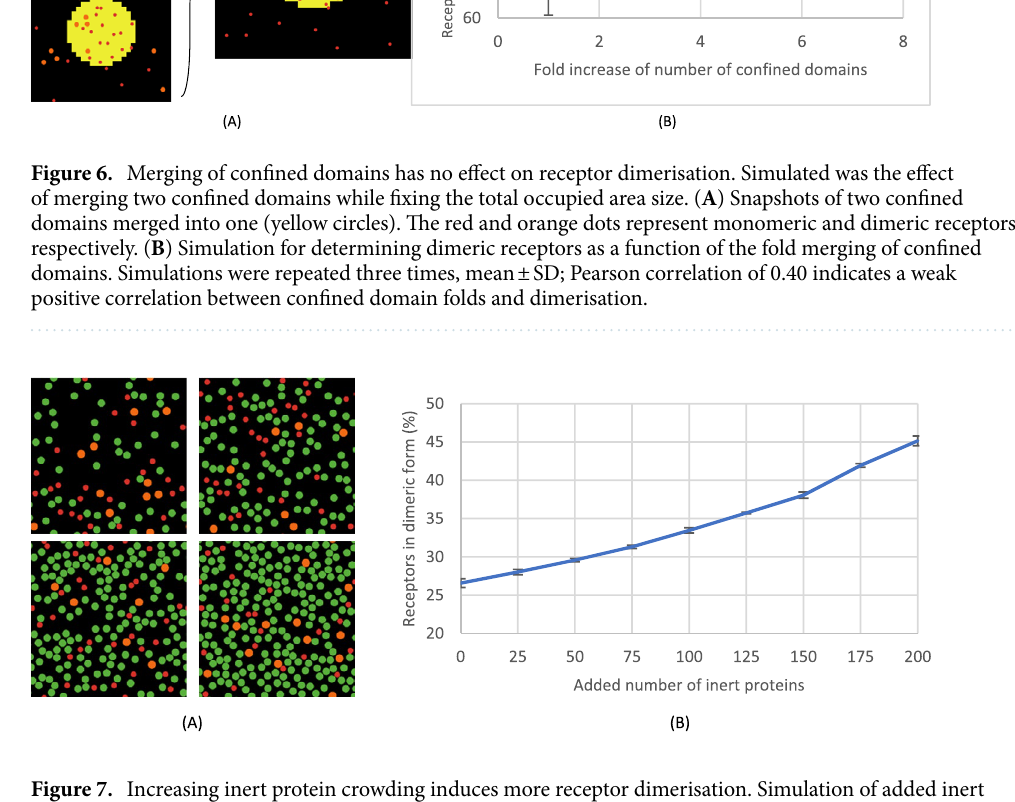
(Fig. 8A). According to the Stokes–Einstein relation 39 , diffusivity may be expected to increase since smaller